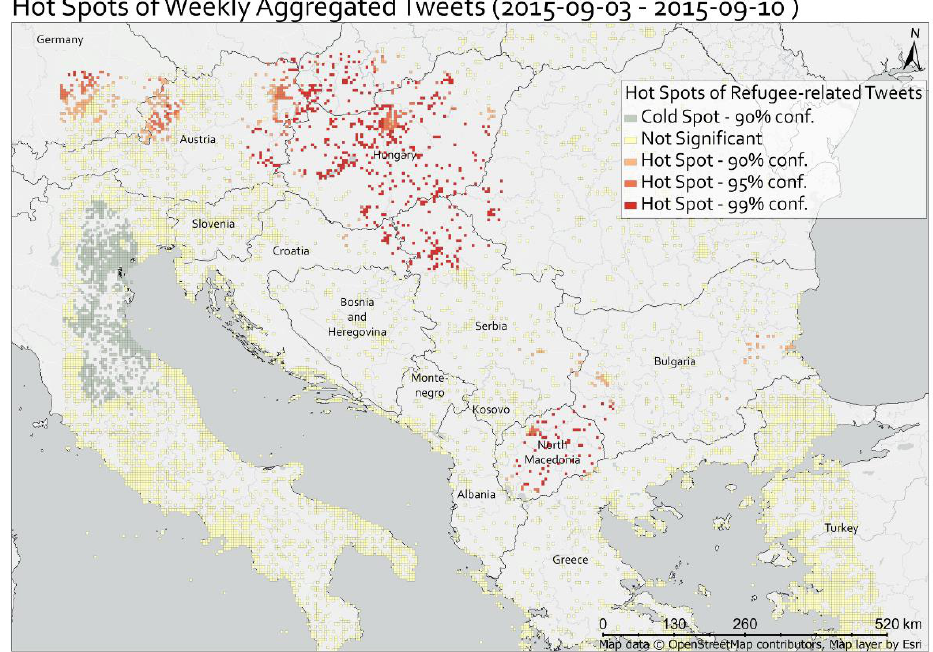
Figure 16. Weekly hot spots of aggregated relevant tweets from 3 September 2015–10 September 2015. Reprinted from map data © OpenStreetMap contributors, map layer by Esri, under a CC BY 4.0 license.